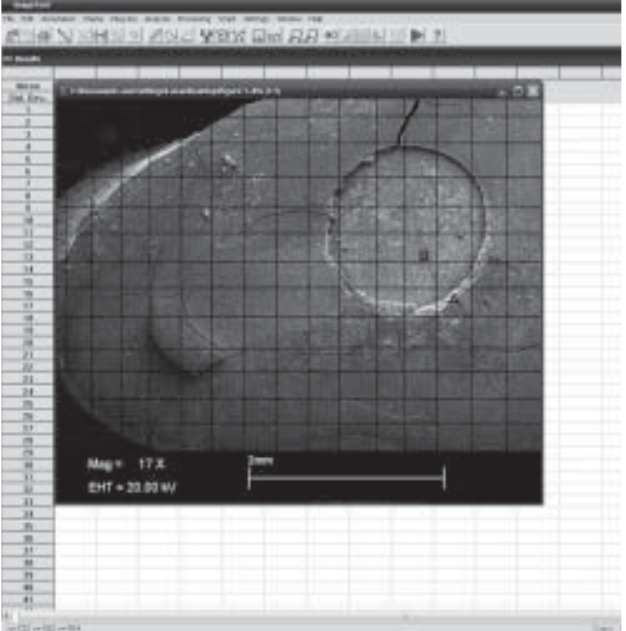
Figure 1. Software Image Tool used for evaluation of the apical obturation from specimen of Group I. Area occupied by root canal sealer (A) and area corresponding to Resilon (B) (×20 magnification).